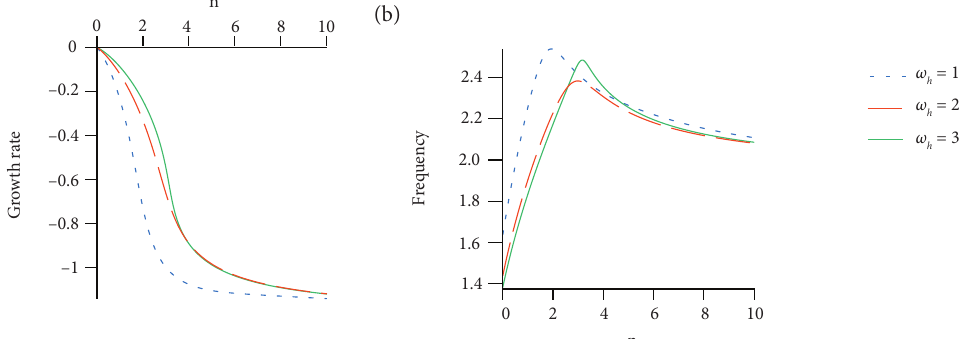
Figure 19. Thermoacoustic characteristics of a ducted resonator as resonator frequency varies (1L mode, τ = 0.6, x = 0.10, x = 0.5, V = 0.2) showing (a) growth rate and (b) frequency. f h